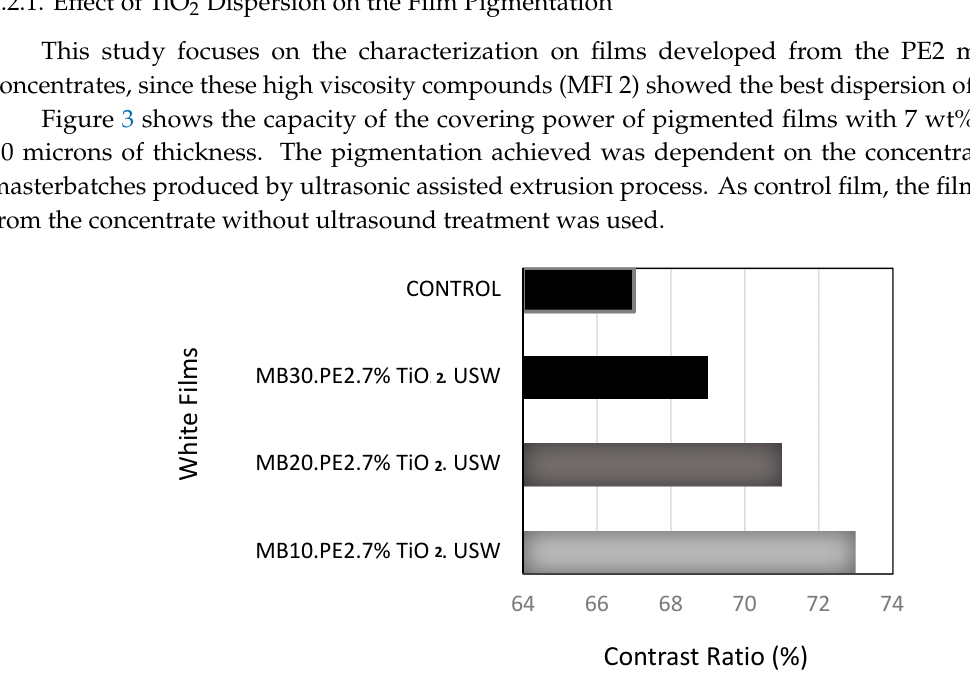
Figure 4. SEM images at 20,000 × of pigment dispersion (7 wt% TiO 2 ) in films prepared using the masterbatch MB10.PE2. USME-VF. ( a ) MB10.PE2.7% TiO 2 control; ( b ) MB10.PE2.7% TiO 2 .USW.